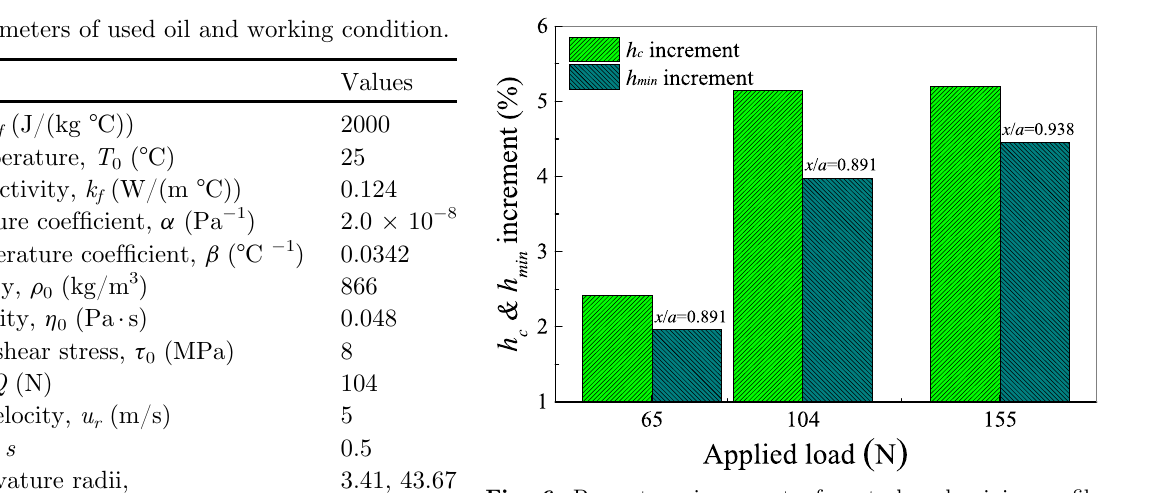
Fig. 6. Percentage increment of central and minimum fi lm thicknesses with inertia force at varied applied load.